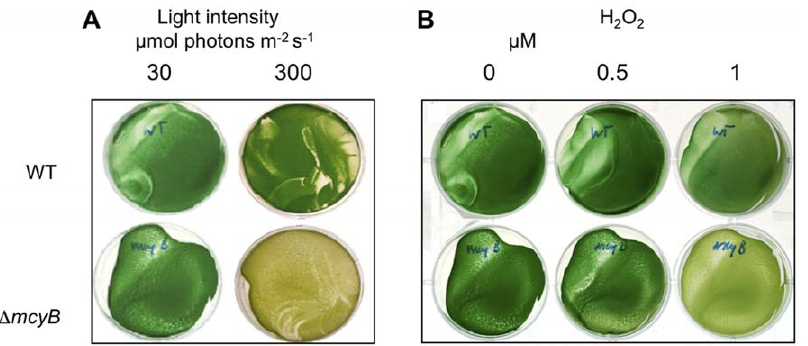
Figure 7. Photographs of M.aeruginosa PCC 7806 wild type (WT) and D mcyB mutant. A)grown on 6-well plates for five days under low light (30 m mol photons m 2 2 s 2 1 ) or high light (300 m mol photons m 2 2 s 2 1 ) conditions, B)grown on 6-well plates for five days under low light conditions with increasing concentrations of H 2 O 2 supplemented to the medium.